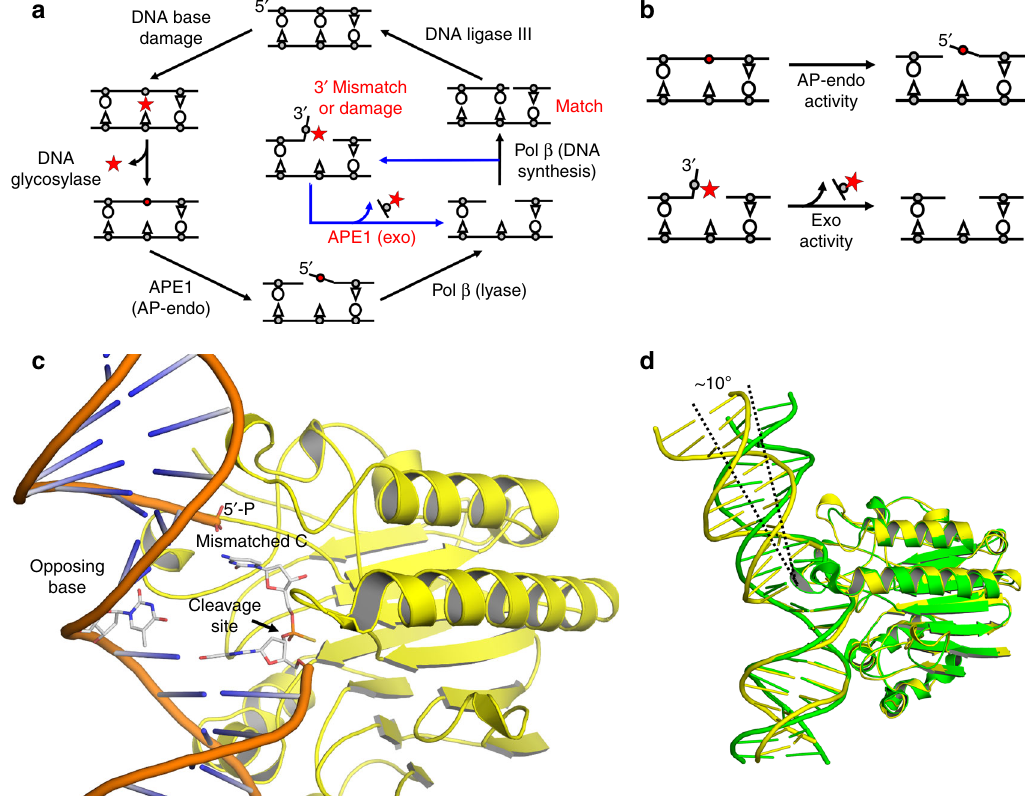
Fig. 1 APE1 is multifunctional during BER. a Schematic of the BER pathway (black) showing the role of APE1 AP-endo activity and a proposed role for the APE1 exo activity (blue) in proofreading 3 ʹ mismatches and removing 3 ʹ end damage. DNA damage and mismatches are highlighted in red. b APE1 AP-endo and exo functions. c Overview of high-resolution APE1-DNA exo substrate complex. The site of cleavage is indicated by the arrow. The 3 ʹ mismatched cytosine, its fl anking base, and the opposing base are shown in stick format (gray carbons). d An overlay of the APE1 exo substrate complex in yellow with APE1 AP-endo substrate complex (PDB 5DFI, green) showing the difference in DNA